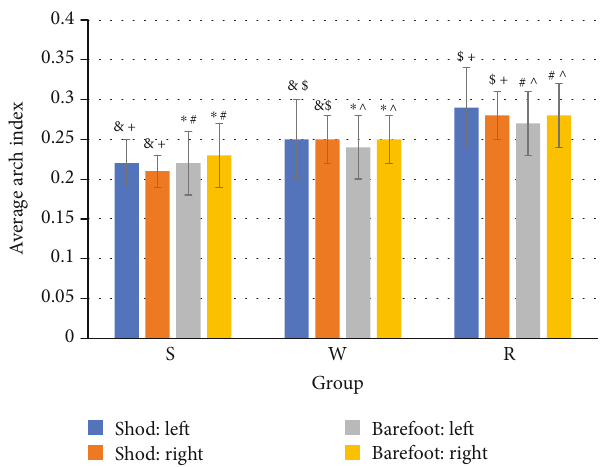
Figure 1: Mean ( ± SD) arch index from EMED while standing (S), walking (W), and running (R) in barefoot and shod males. Table 1: Comparisons of arch index in left and right feet from standing to walking and running in shod and barefoot males.